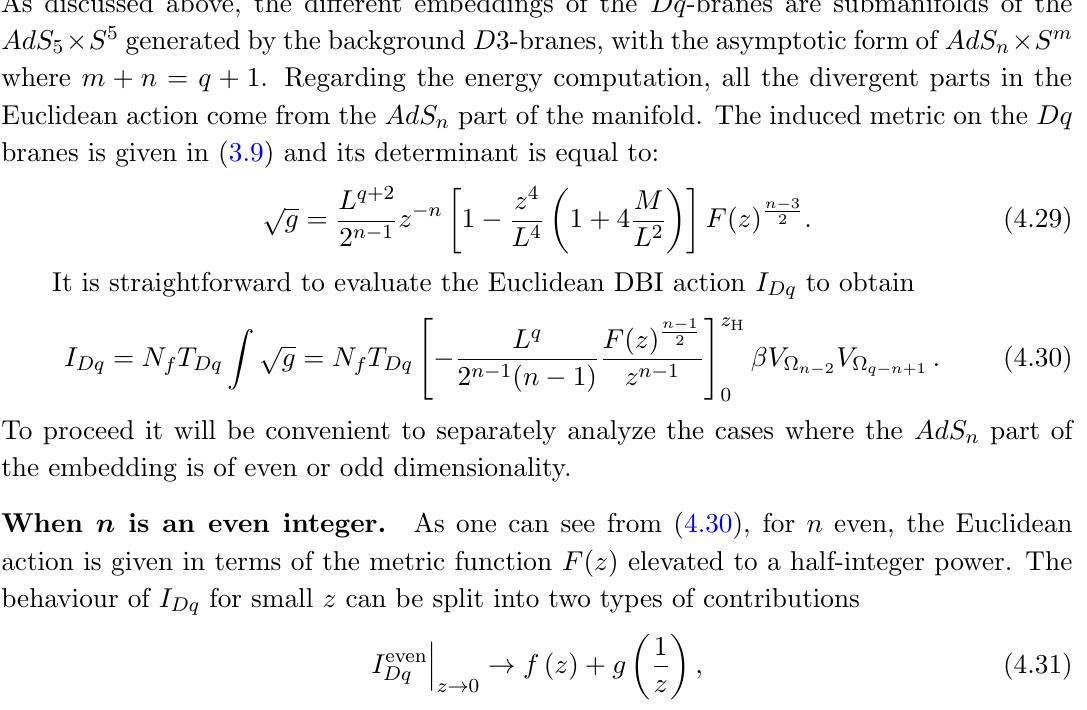
Figure 3 . The function K D 5 vs temperature, starting from the minimum value x min = horizontal orange line is the value to which it asymptotes, namely 1 =